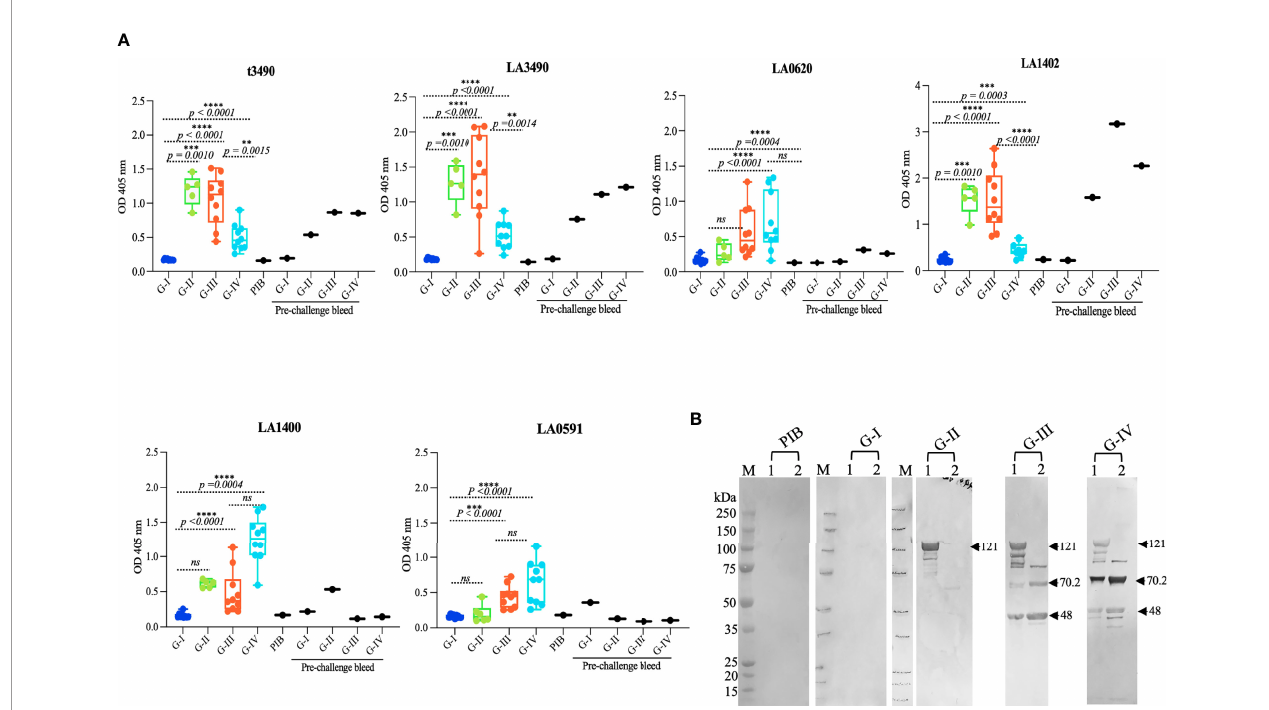
FIGURE 4 | IgG responses to recombinant VM protein immunization. (A) Antibody titers were measured in each study group pre-and post-challenge against individual VM proteins in triplicate using ELISA. Each data line represents the average IgG response of each animal (n-10). Box and whiskers plots represent the antibody titers against t3490, LA3490, LA0620, LA1402, LA1400, and LA0591, respectively. The four-study groups include G-I: PBS, G-II: t3490, G-III: VM mix and G-IV: VM unlabeled. The box boundaries indicate the median and interquartile ranges and the whiskers denote the maximum and minimum values. Statistical analysis was performed by t-test and the non-parametric, unpaired, two tailed Mann Whitney test p< 0.0001 values were considered signi fi cant. (B) Aliquot from immunized recombinant puri fi ed VM proteins were run in 4 ± 12% SDS-PAGE then transferred to nitrocellulose membrane for Western blot analysis. The membrane was probed probed with pooled sera (1:100 dilution) collected post-challenge. PIB denotes pre-immunized bleed, served as control. VM proteins were recognized by sera from G-II, G-III, and G-IV. Lane 1 shows VM mix protein (LA3490, LA0620, LA1402, LA1400 and LA0591) and Lane 2 shows VM unlabeled proteins (LA1400 and LA0591). Arrows shows expected size of VM proteins. M represents molecular weight markers. **p < 0.05, ***p < 0.001, ****p < 0.0001